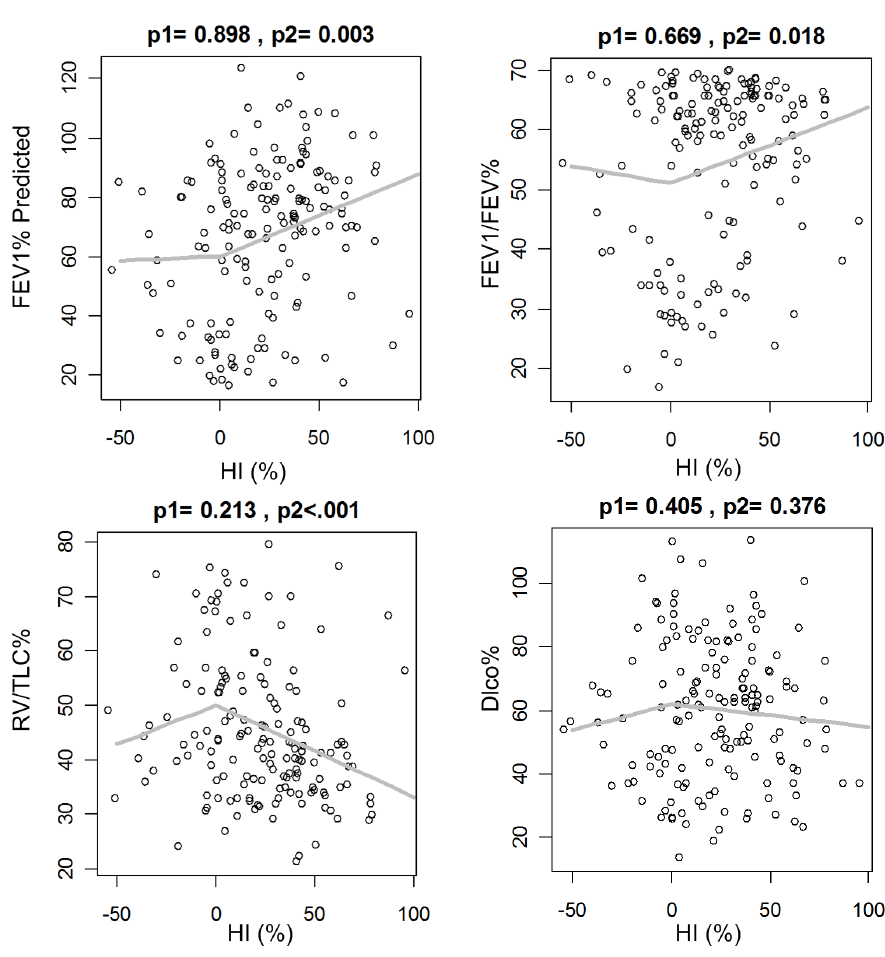
Figure 3. Scatter plots of pulmonary function measures and emphysema heterogeneity (HI%) for COPD patients. The grey line represents the estimated pulmonary function as a function of HI%. p1 denotes the p-value of HI% 2 =min(0%, HI%) in the piecewise linear regression, and p2 corresponds to the p-value of HI% + =max (0%, HI%).